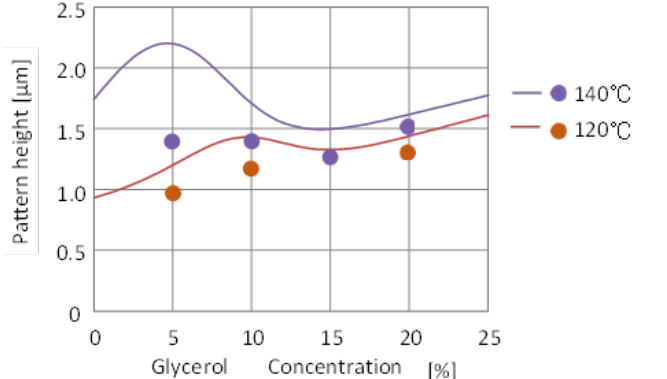
Figure 5. Predicted pattern height (solid lines) and verification experimental results (dots) for various glycerol concentrations at 120 °C and 140 °C based on experimental learning data at 110 °C, 130 °C, and 150 °C.